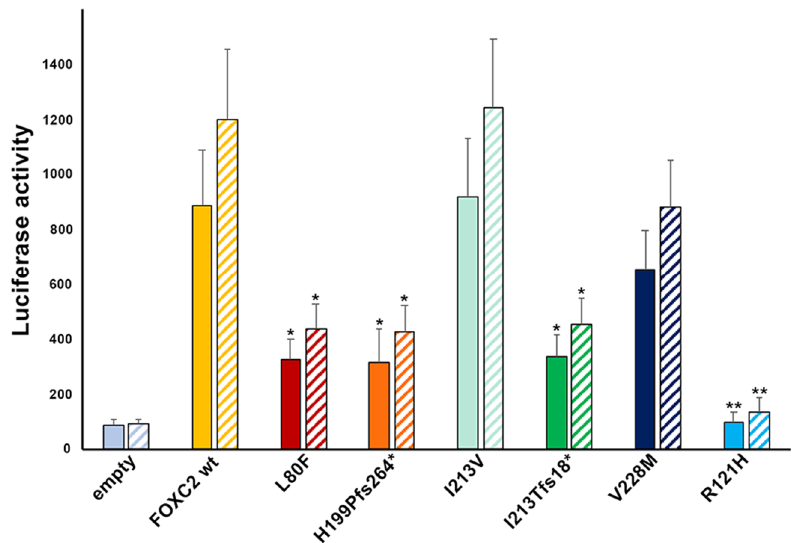
Figure 4. Transactivation activity of control and mutant FOXC2 proteins. Luciferase assays were used to measure protein transactivation. Transactivation activity of control and mutant FOXC2-GFP fusion proteins (squares with uniform colors) and mutant FOXC2 proteins without any tag (bars with diagonal stripes), compared with that of empty vector in HeLa cells, is indicated in fluorescence units (vertical axis). Thick bar: mean value, error bar: SD. Significant differences were detected by Student’s t -test. p -values <0.05 and <0.01 were considered significant and indicated * and **, respectively.